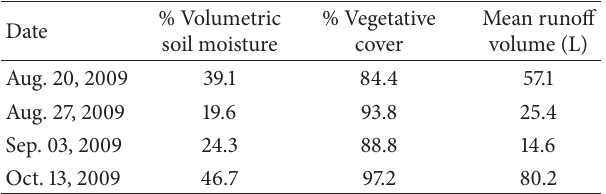
Table 1: Mean volumetric soil moisture, percent vegetative cover, and mean runoff volume from each of the four blocks used in this